Question: In a single sentence, describe what this figure presents.
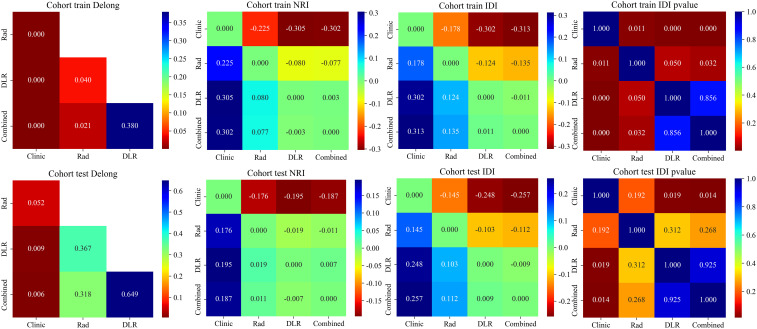
Answer: Comparison of the clinical, radiomics, deep learning radiomics, and combined models by DeLong test, NRI, and IDI in the training and validation cohort.